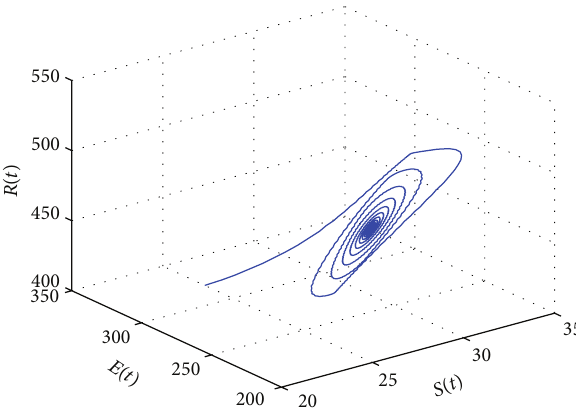
Figure 6: The phase plot of the states 𝑆 , 𝐸 , and 𝑅 for 𝜏 2 = 45.5000 < 52.4927 = 𝜏 20 .